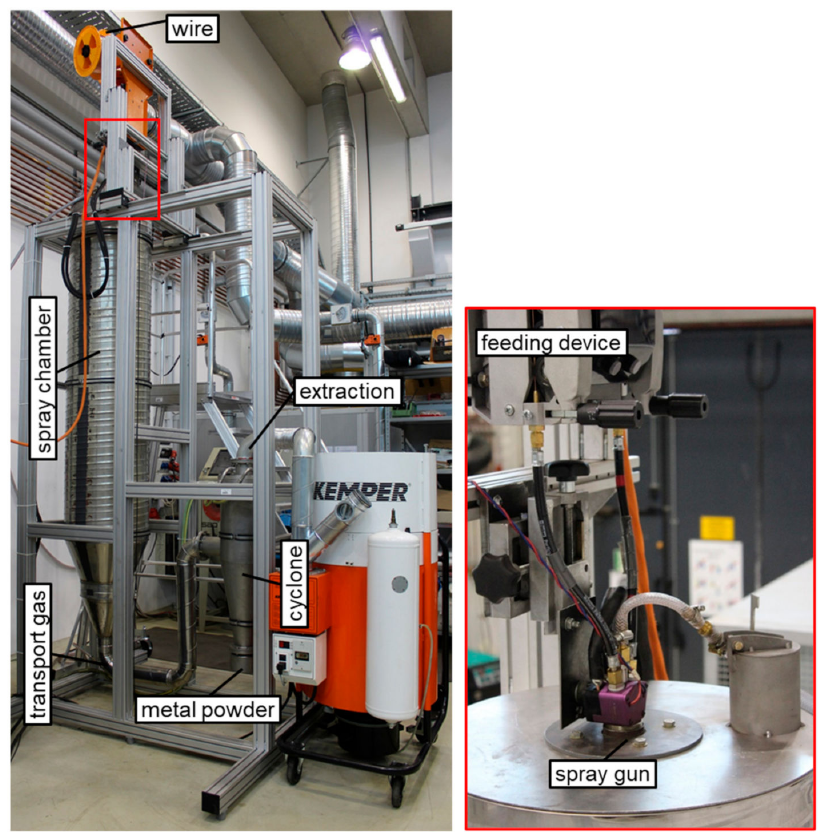
Figure 2. Experimental setup for the production of metal